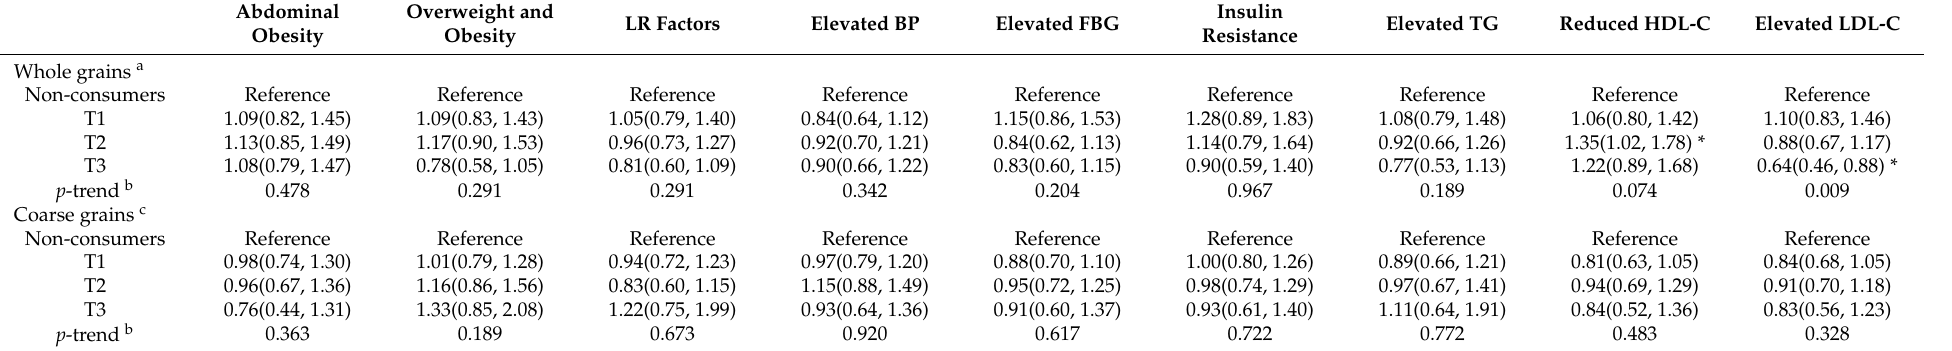
Table 3. Associations of baseline intakes of whole grains and coarse grains with each CMF among Chinese adults, CHNS.